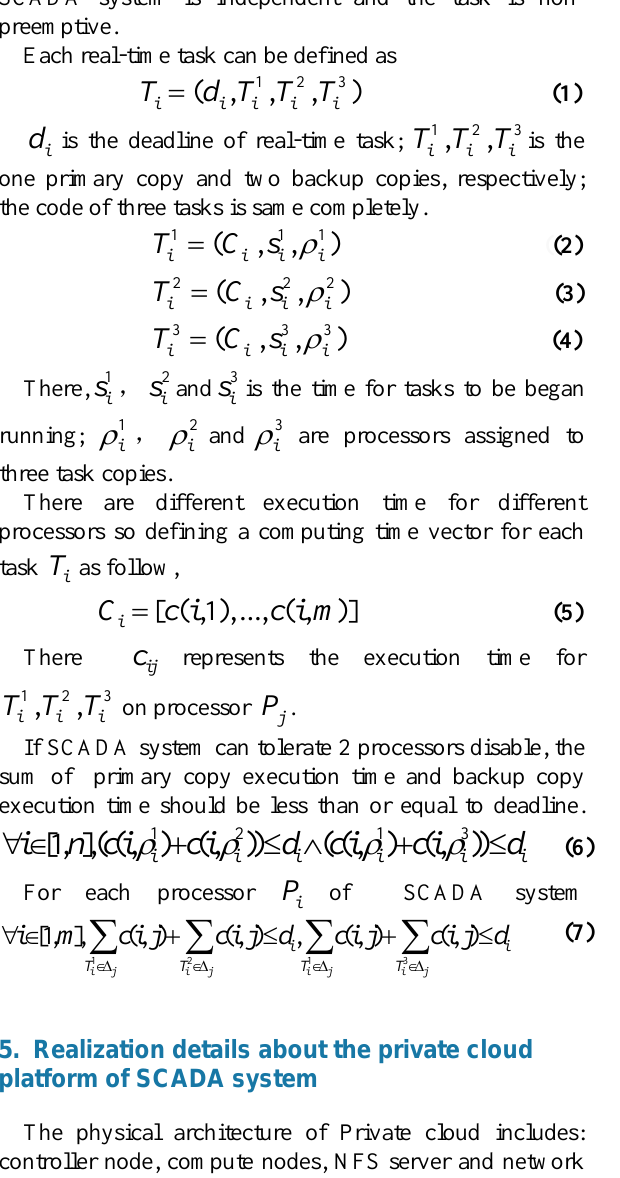
Figure5. The logical architecture of private